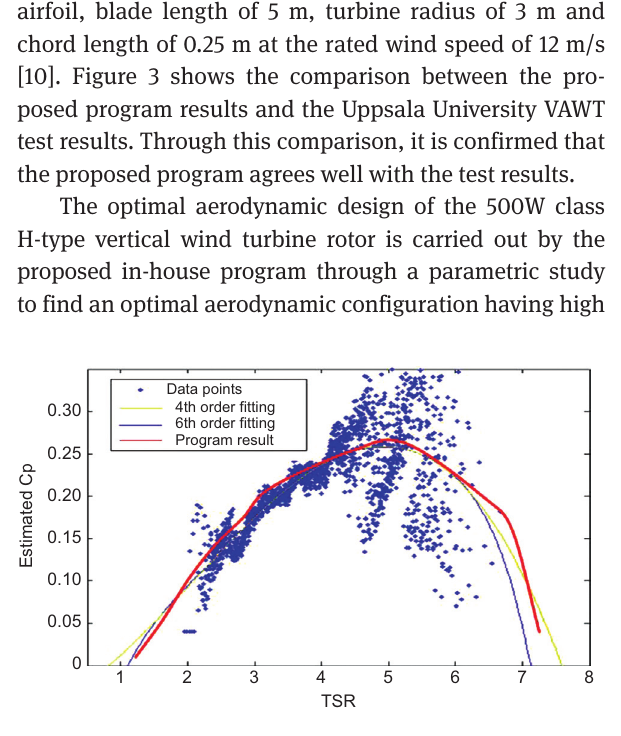
Figure 2 Front page of the proposed user friendly aerodynamic design program of VAWT.